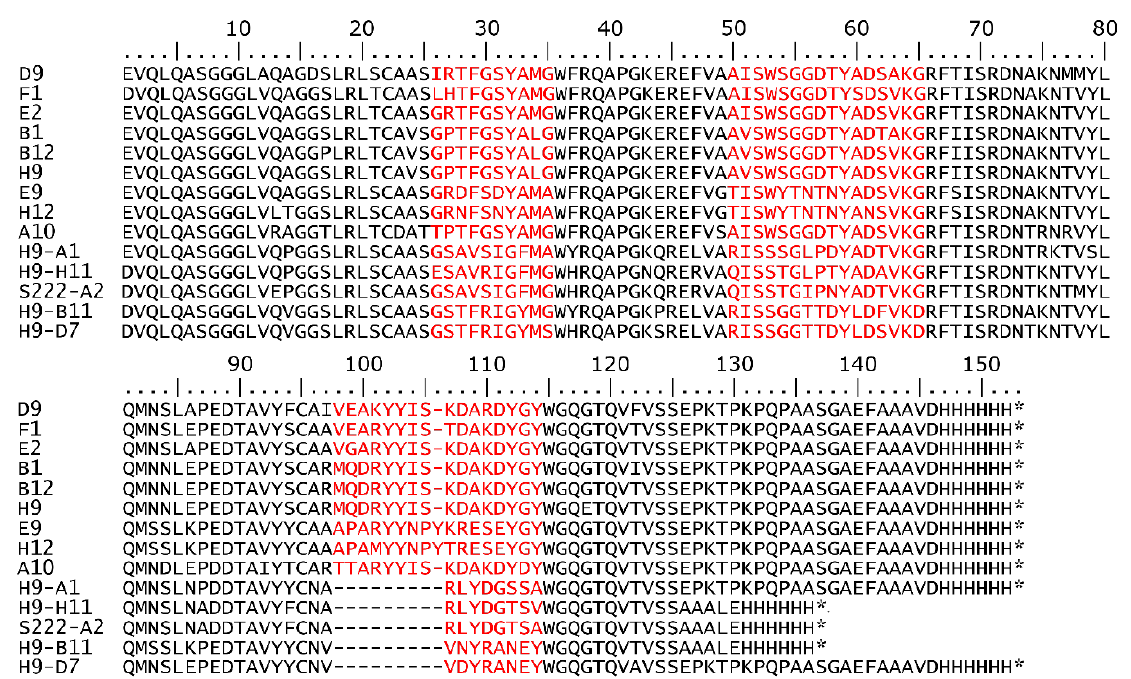
Figure 1. Sequences of isolated SEB binders. Complementarity determining regions (CDRs) have been colored red for clarity. The sequences of three of the sdAbs (H9-H11, S222-A2, and H9-B1) are shorter as they are shown lacking sequence from the upper hinge